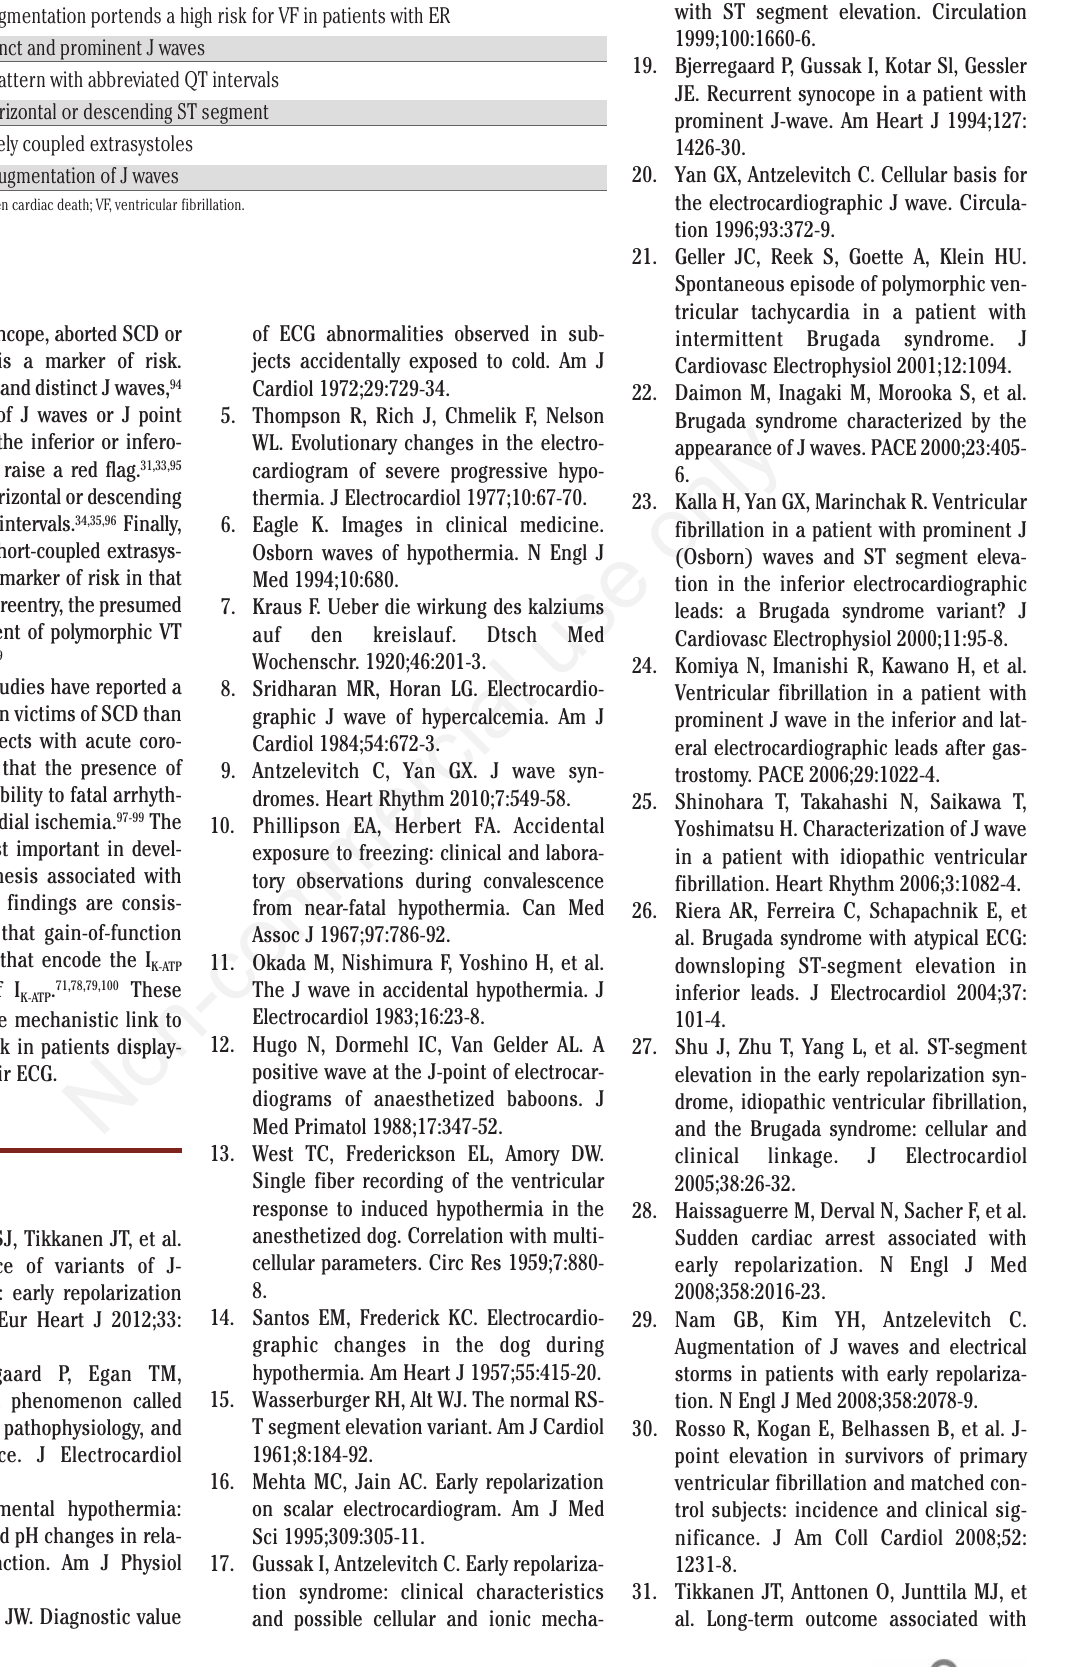
Table 4. Risk stratification of patients with early repolarization pattern. Who is at risk? Association of ER pattern with SCD, unexplained syncope, or unexplained family history of SCD J point or ST segment elevation of 0.2 mV or greater in inferior and infero-lateral or global leads Transient J wave augmentation portends a high risk for VF in patients with